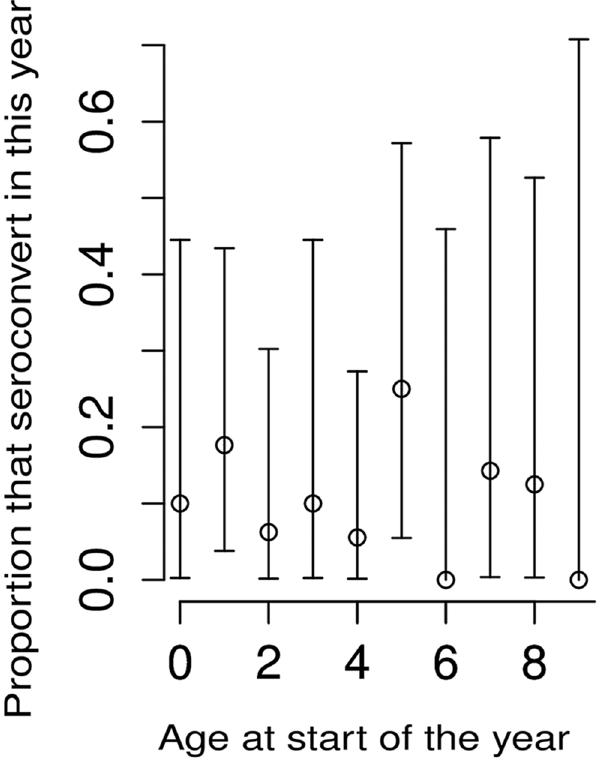
Fig 6. Proportion of dengue na ï ve subjects at enrolment that seroconverted at 12 months.